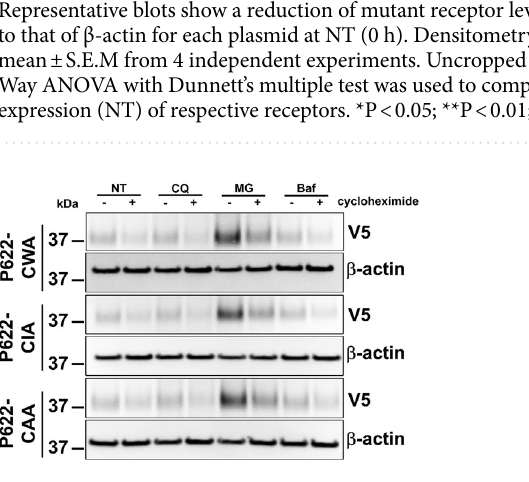
Figure 4. Proteasomal but not endosomal or lysosomal pathways control degradation of ECL2 mutants. ( a ) HEK cells were transfected with the same dose of plasmids (1 µg) expressing P622-CWA, P622-CAI, and P622- CAA. Cells were then pre-incubated with chloroquine (CQ; lysosomal acidification inhibitor, 25 µM), MG-132 (MG; proteasomal inhibitor, 1 µM), and bafilomycin A1 (Baf; inhibitor of v-ATPase, endosomal acidification, and late-stage vesicle maturation, 10 nM) overnight, followed by an 8-h incubation with cycloheximide (100 µg/ ml). Total cell lysates were run on SDS-PAGE, transferred to PVDF membranes, and probed with V5 and β-actin antibodies. Representative blots from 3 independent experiments are shown. Uncropped blots are provided in Supplementary Fig.